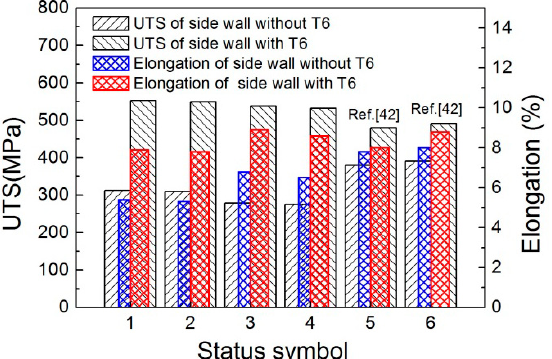
Figure 15. Effect of T6 on the mechanical properties of the rheoformed composite parts, the thixoformed composite parts, and thixoformed 7075 aluminum alloy parts. 1 means side wall of the thixoformed composite part, 2 means bottom of the thixoformed composite part, 3 means side wall of the thixoformed 7075 aluminum alloy, 4 means bottom of the thixoformed 7075 aluminum alloy, 5 means side wall of the rheoformed composite part and 6 means the bottom of the rheoformed composite part.